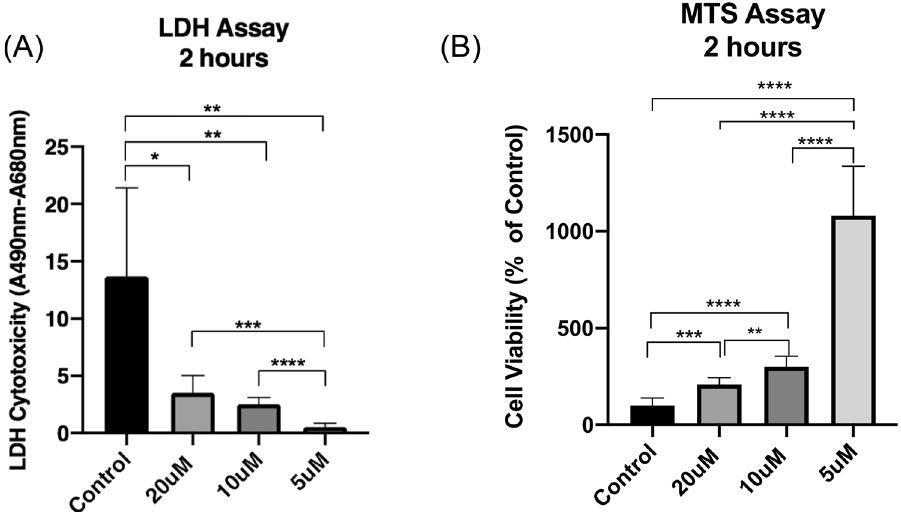
Figure 1. Effects of NIM-811 treatment on ischemic human myoblasts. Ischemic Human myoblasts were treated with (0–20 μM) NIM-811 for 2 h following the exposure to hypoxia for 6 h. Data shown are for cell viability measured by MTS assay ( A ) and cell toxicity in different groups as determined by LDH assay ( B ). Data are expressed as mean ± SD (n = 6). ****P = 0.0001, ***P = 0.0005, **P = 0.0022 and *P =